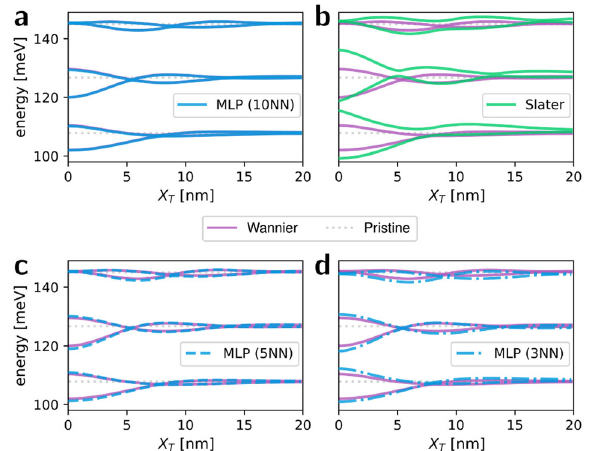
Fig. 9 Quantum dot benchmark of fl ower defect. Level spectrum landscapes calculated with different TB parametrizations of the fl ower defect in SLG compared against the Wannier parametrization [ a MLP(10NN), b Slater – Koster, c MLP(5NN), d